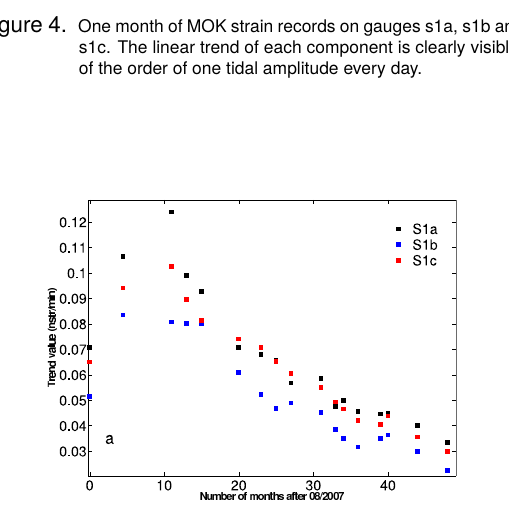
whichcouldperturbthesignalbyshearorcouplingvariationsdue to uneven